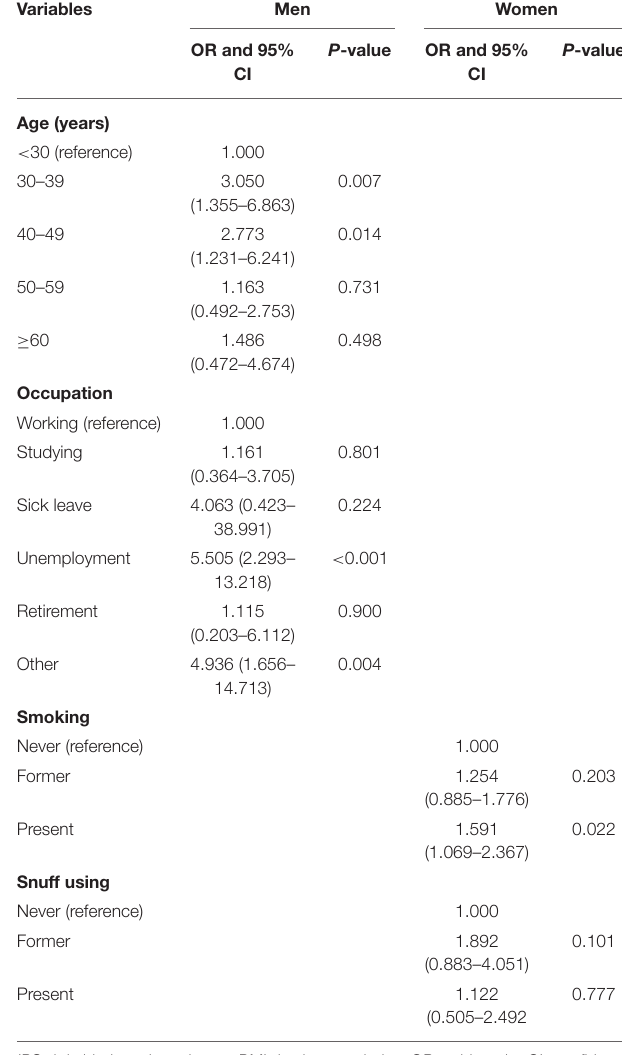
TABLE 5 | Associations between age, sex, occupation, and smoking and specific symptoms. Variables